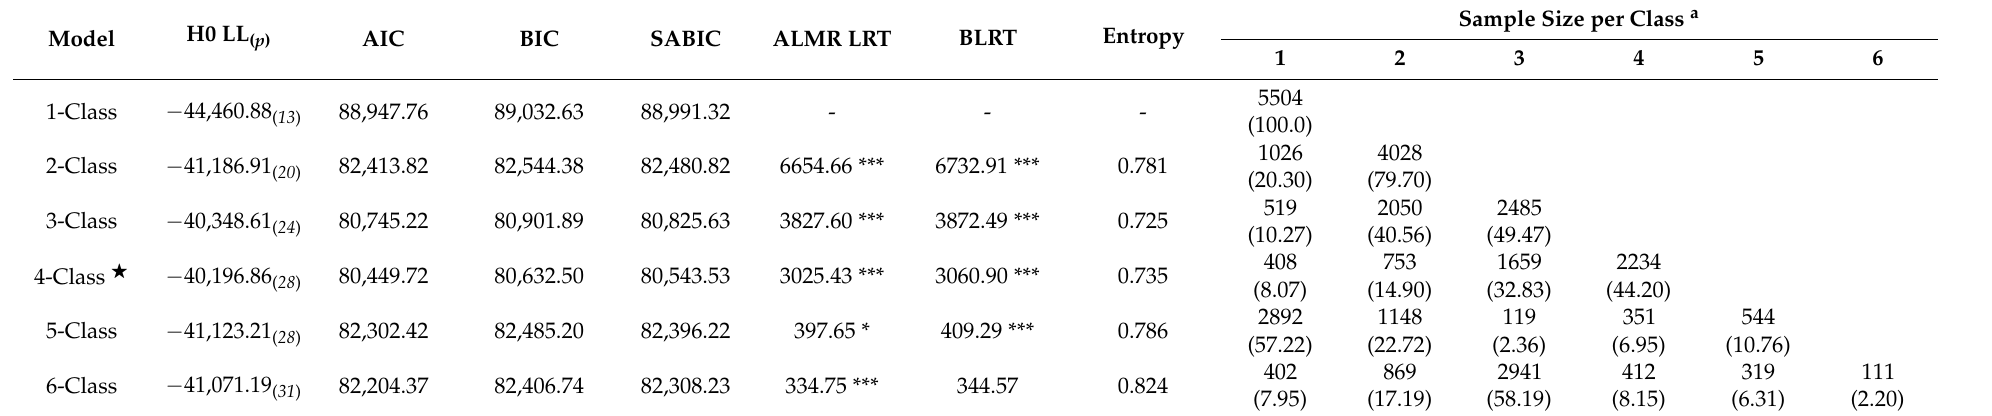
Table 3. Fit indices for GMM